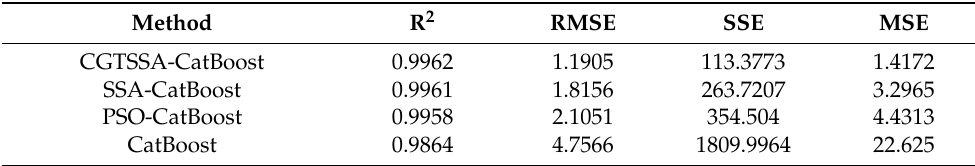
Table 5. Prediction results of various